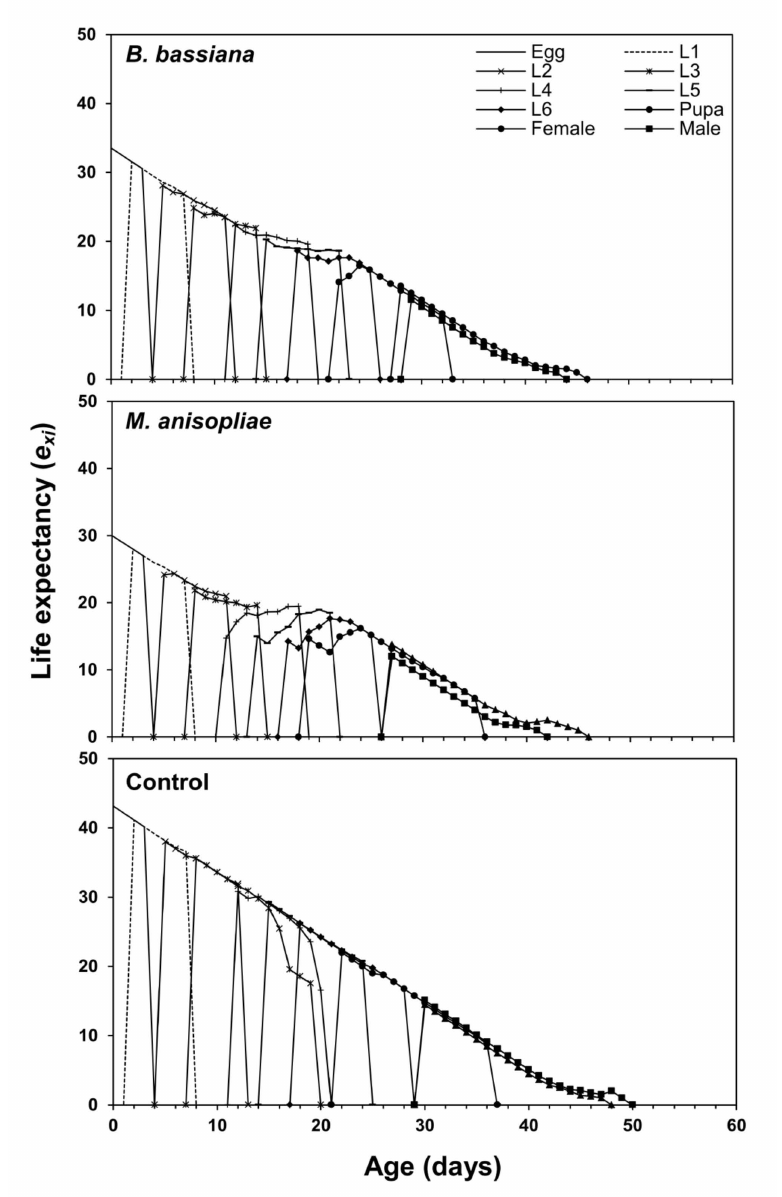
Figure 3. Age-stage-specific life expectancy ( e xj ) of Spodoptera frugiperda fed on endophytic colonized and non-colonized